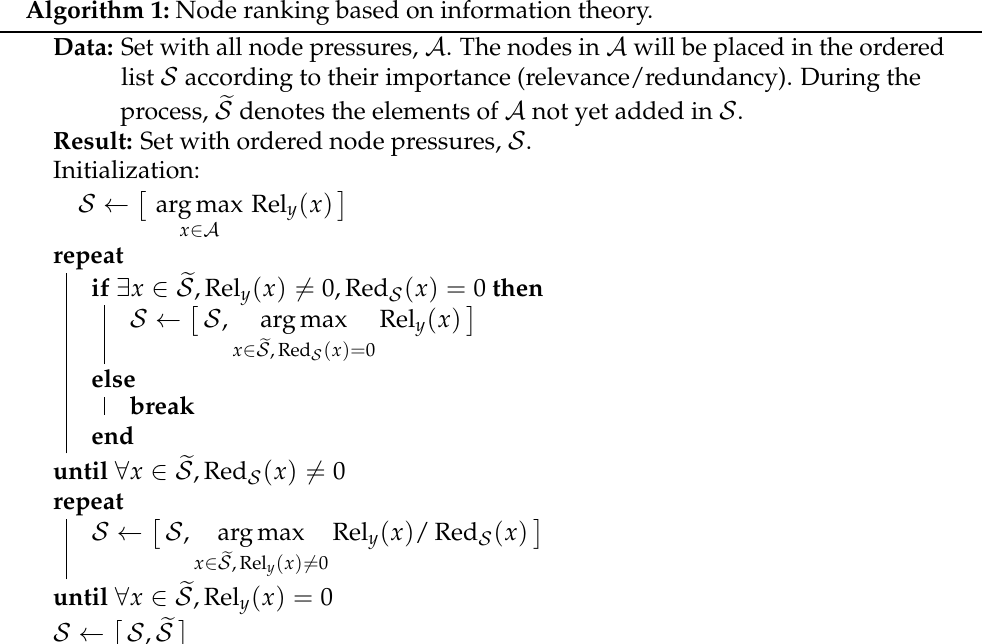
Algorithm 1: Node ranking based on information